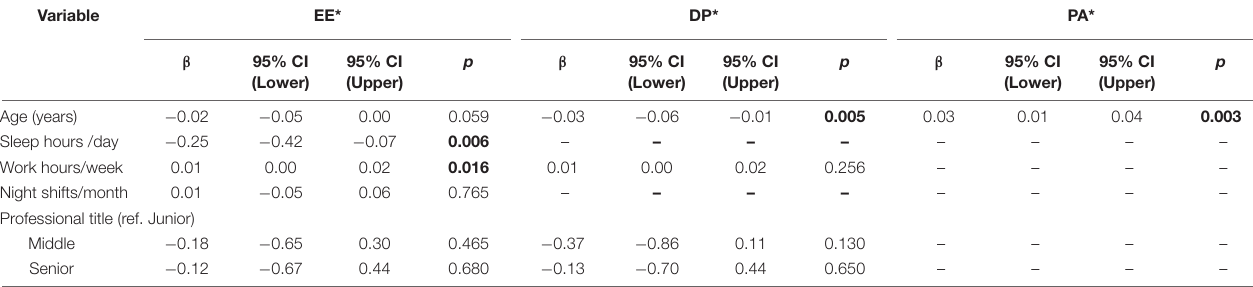
*Transformed into standardized normal variate. Bold value for p < 0.05. linear regression analysis for male and female